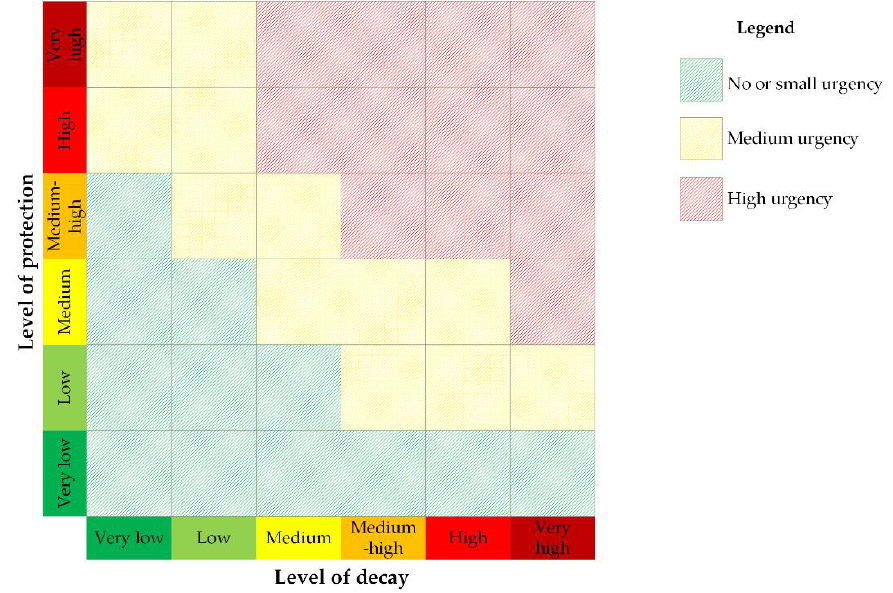
Figure 2. The link between the levels of decay and the levels of protection in historic buildings. The colour code highlights the urgency need for adaptation interventions.